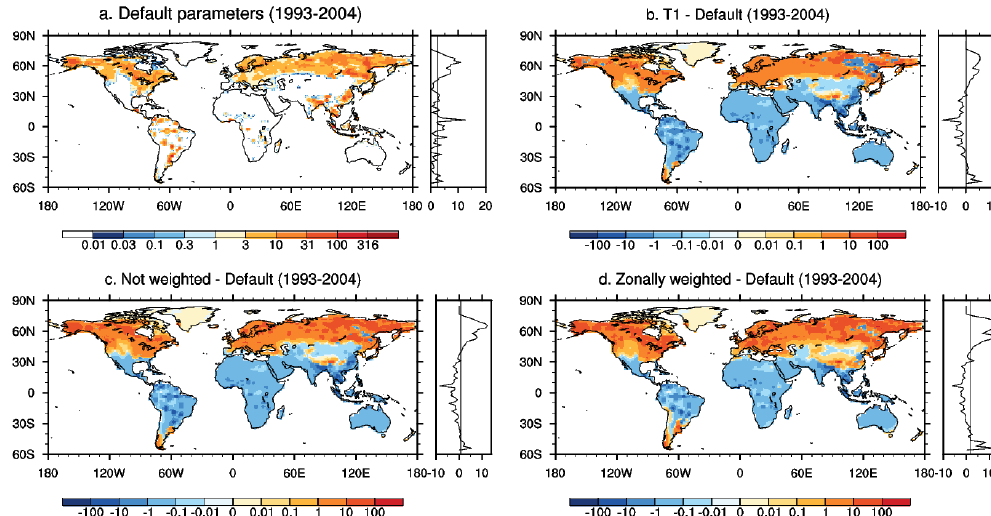
Figure 12. Average methane emissions (mgCH 4 m − 2 d − 1 ) simulated by CLM4.5bgc for (a) default parameters, (b) differences between de- fault parameters and 11-dimensional optimization trial T1, (c) differences between default parameters and optimization trial with unweighted sum of RMSE, and (d) differences between default parameters and optimization trial with zonally weighted sum of RMSE. Zonal means are shown on the right side of each spatial